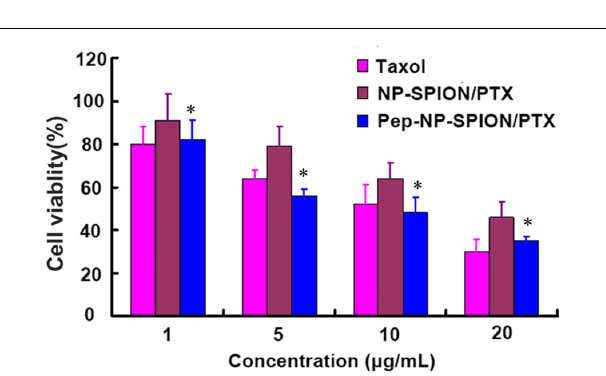
FIGURE 6 | In vitro cytotoxicity of Taxol R (cid:13) , NP-SPION/PTX and Pep-NP- SPION/PTX at various concentrations at 48 h. Data represented mean ± SD ( n = 3). ∗ p < 0.05 significantly lower than that of